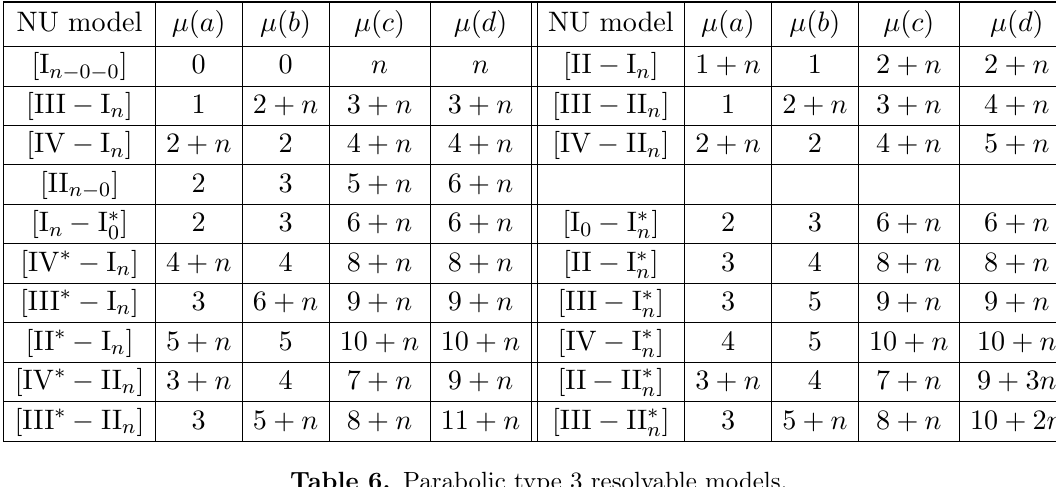
Table 6. Parabolic type 3 resolvable